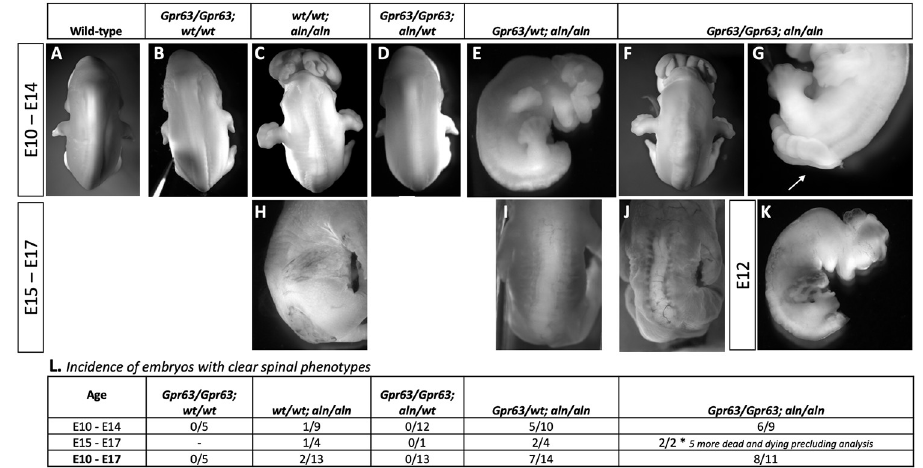
Fig 10. Gpr63 del/del ; Ttc21b aln/aln double mutants have increased incidence of neural tube defects. Embryos of multiple genotypes from a Gpr63 del/wt ; Ttc21b aln/wt intercross are shown at stages from E10-14 (A-G, K) or E15-17 (H-J). Gpr63 del/del ; Ttc21b aln/aln double mutants do not survive to term and show multiple phenotypes which are more severe than either single mutation including spina bifida aperta (G). (L) Incidence of neural tube closure defects of any severity in the embryos resulting from the Gpr63 del/wt ; Ttc21b aln/wt intercross. Note the dramatic increase in penetrance in double mutants (8/11) as compared to any other genotype.